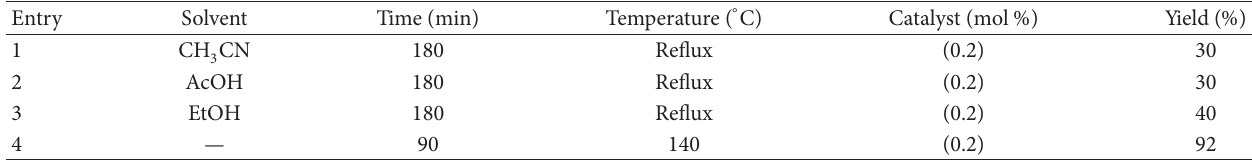
T 1: Solvent effect for the synthesis of (5-a)